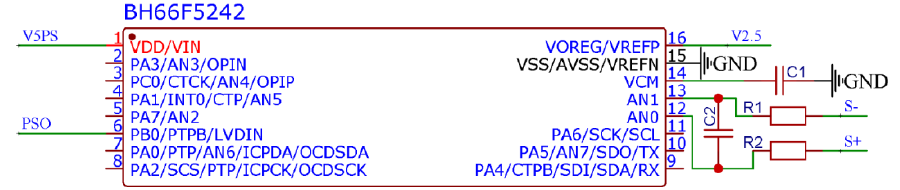
Figure 5. Schematic diagram of pulse width modulation circuit.